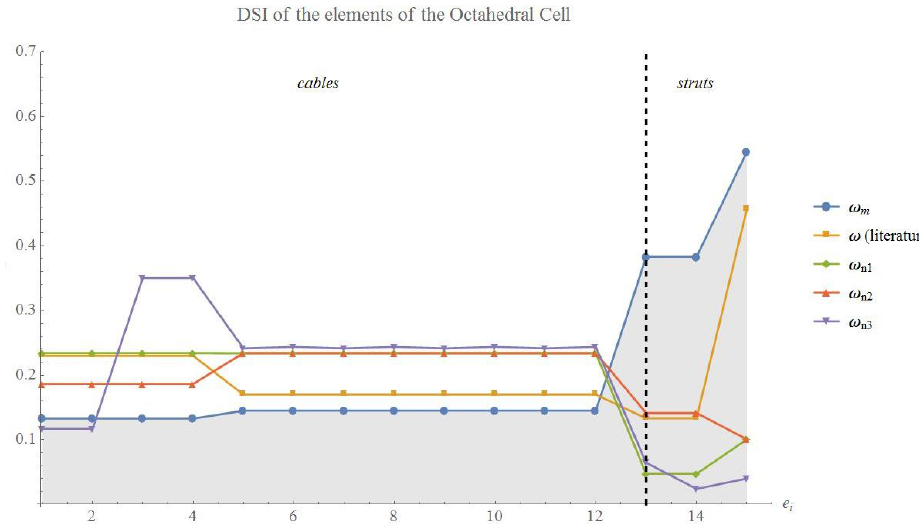
Figure 10: DSI of the elements of the Octahedral cell for different assignments of the axial stiffness